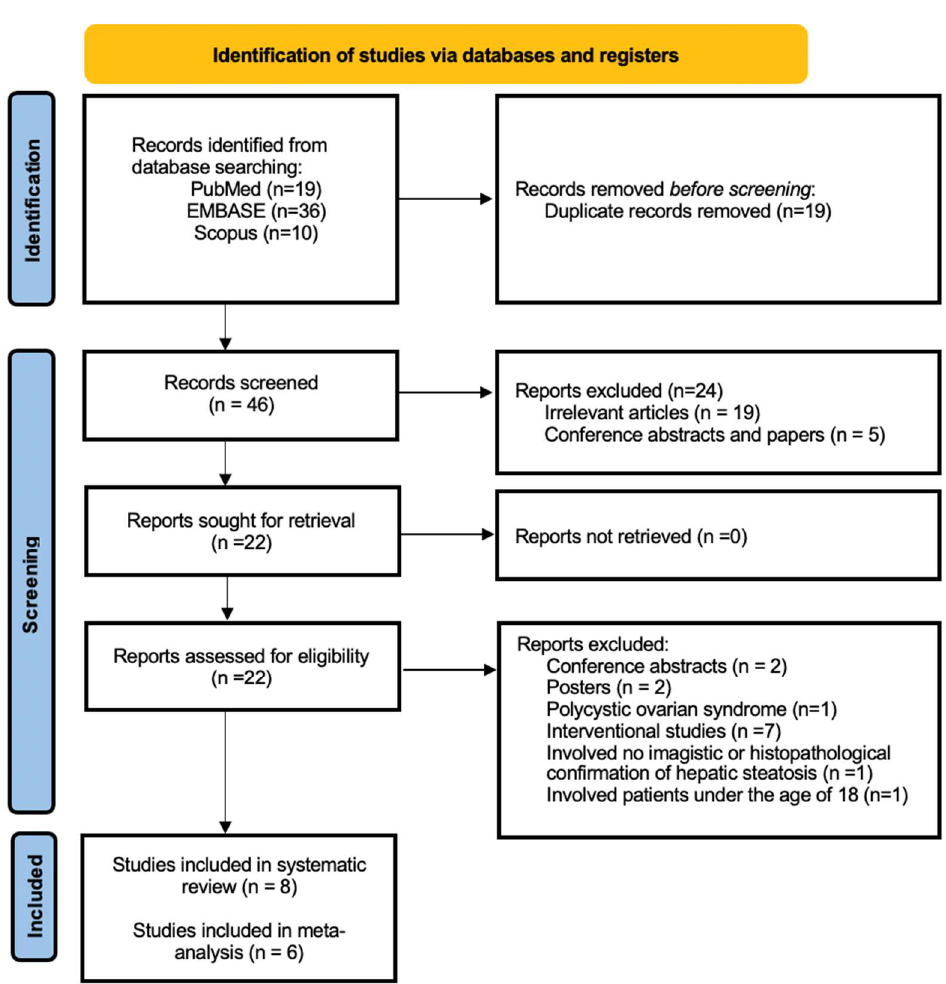
Figure 1. The PRISMA flow diagram of the identification, screening, and inclusion methodology of the studies.